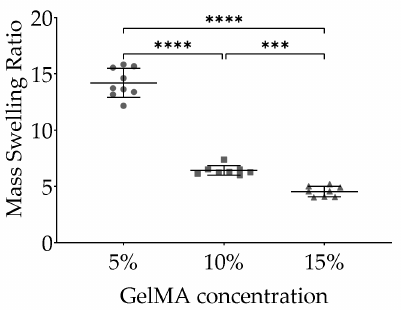
Figure 2. Swelling ratio of GelMA hydrogels. After swelling in DPBS for 1 d and subsequent dehydration the swelling ratio was calculated according to Equation (2). Data derived from three samples per experiment from three independent experiments are shown.. Data are presented as mean with standard deviation. p values are indicated *** p < 0.001 and **** p < 0.0001 according to One-way ANOVA and